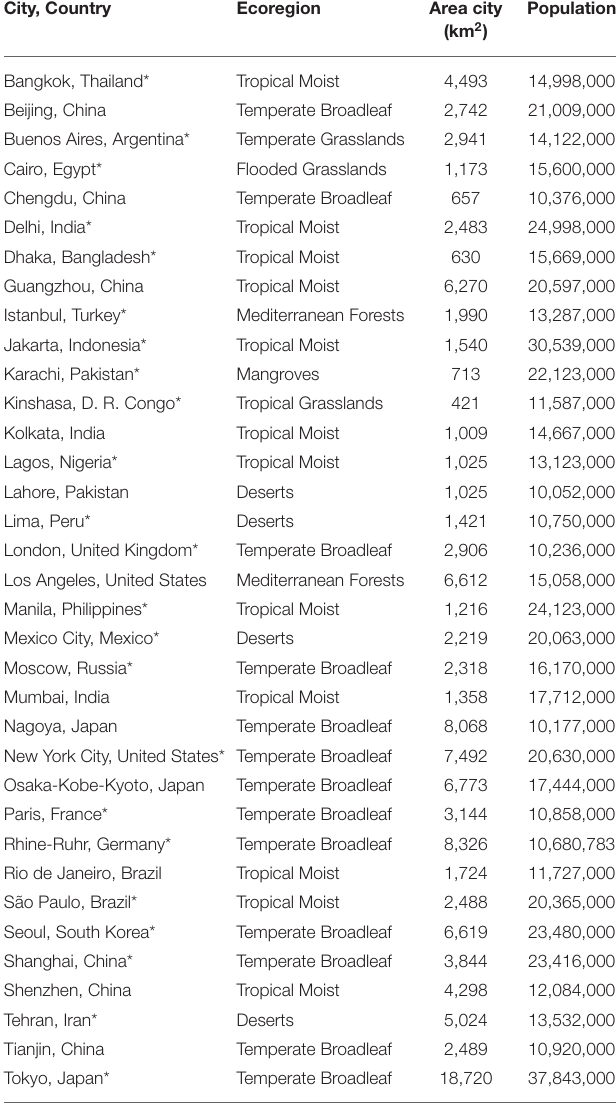
TABLE 1 | Summary of continent and ecoregion for the 35 analyzed megacities in 23 countries, 5 continents. City,